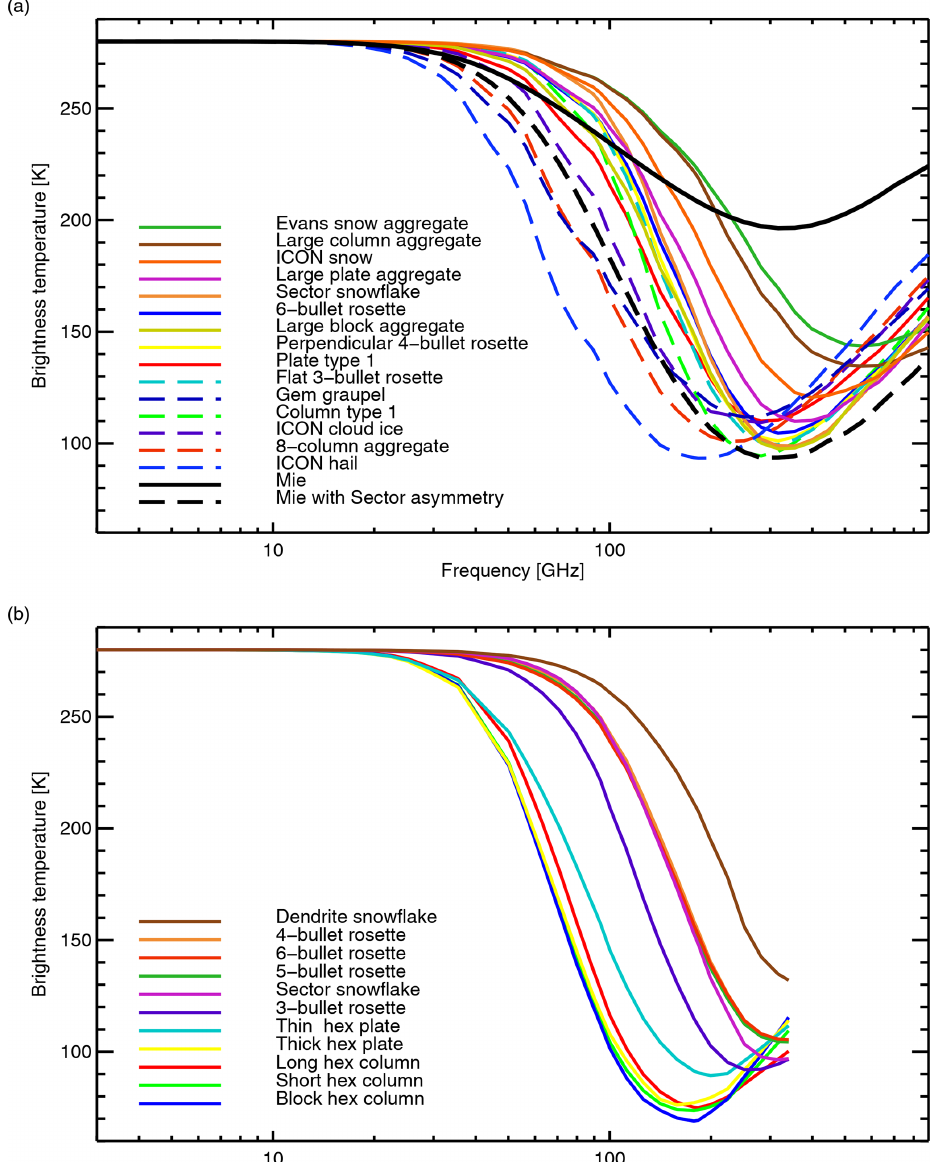
Figure 9. Cloud top upwelling brightness temperatures representing a standard ice or snow cloud at 253K with upwelling below-cloud TB of 280K: (a) ARTS database shapes, and a Mie snow sphere with details as Figs. 1 and 2: (b) Liu (2008) particles. In all cases the F07 tropical PSD has been used and the cloud layer is 2km thick with a water content of l = 1 × 10 − 3 kgm − 3 , as Fig. 8. The line and colour scheme for ARTS shapes is consistent with Fig. 2. Excluding the Mie sphere (black), legends in this figure are ordered by 183 GHz TB, from highest to